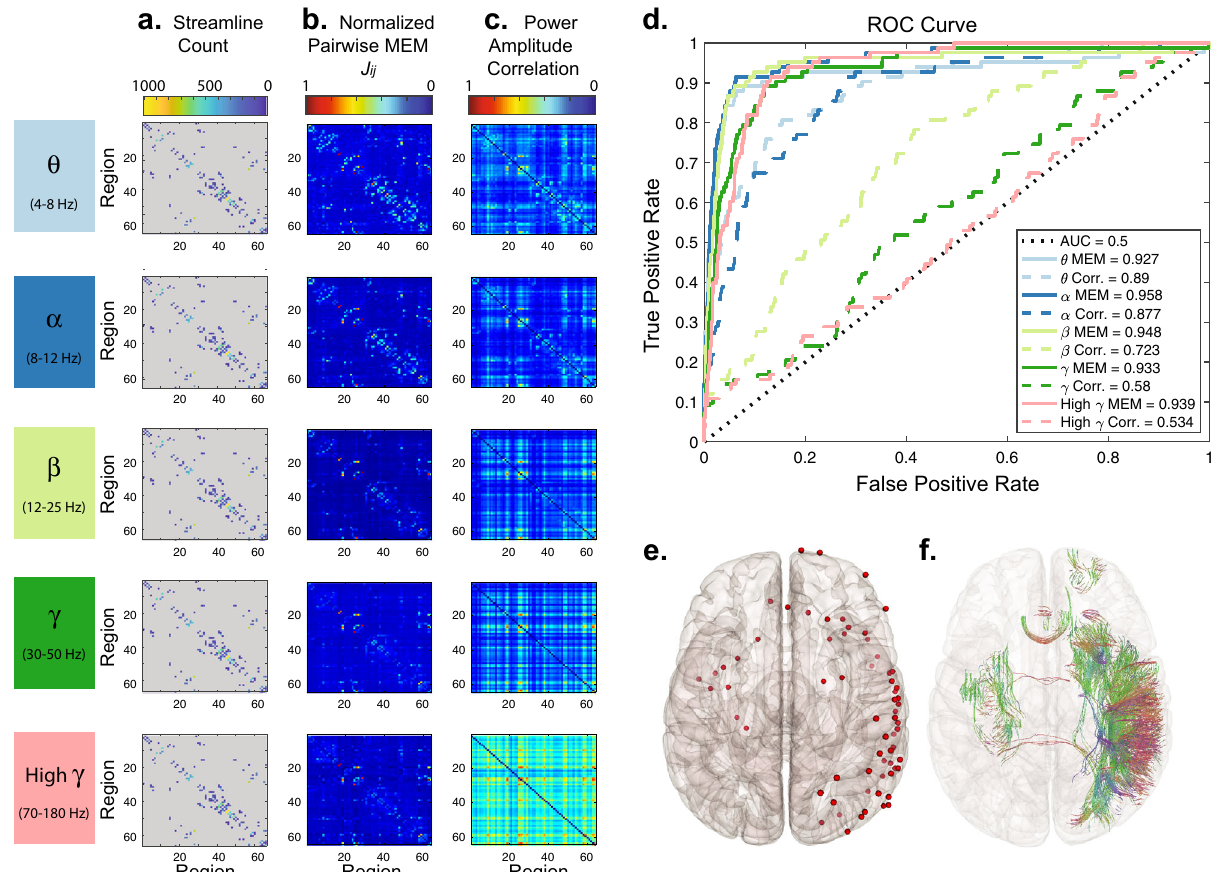
Fig. 4 Predicting structural connectivity from estimates of functional connectivity. a A structural connectivity matrix from a single representative patient (#5), each element of which indicates the number of streamlines estimated between a pair of brain regions. b The interaction matrices, J ij , obtained from 19 h of inter-ictal iEEG power amplitude states (referential montage, binarization threshold = 0) using the pairwise MEM. c The functional connectivity matrices estimated from band-passed binarized power amplitude correlations (i.e., co-activation rates). For regions covered by multiple electrodes, we selected only the electrode closest to the region ’ s centroid for display in these plots as well as in the ROC analysis. d ROC curves for identi fi cation of anatomically connected regions based on interaction matrices (solid lines) and band-passed power amplitude correlations (dashed lines). Lines are color- coded based on the frequency band. e Brain overlay providing the position of the selected electrodes (red dots). f Streamlines connecting the regions covered by the selected electrodes in the same patient. Here the 3-dimensional orientations of the streamlines are coded by